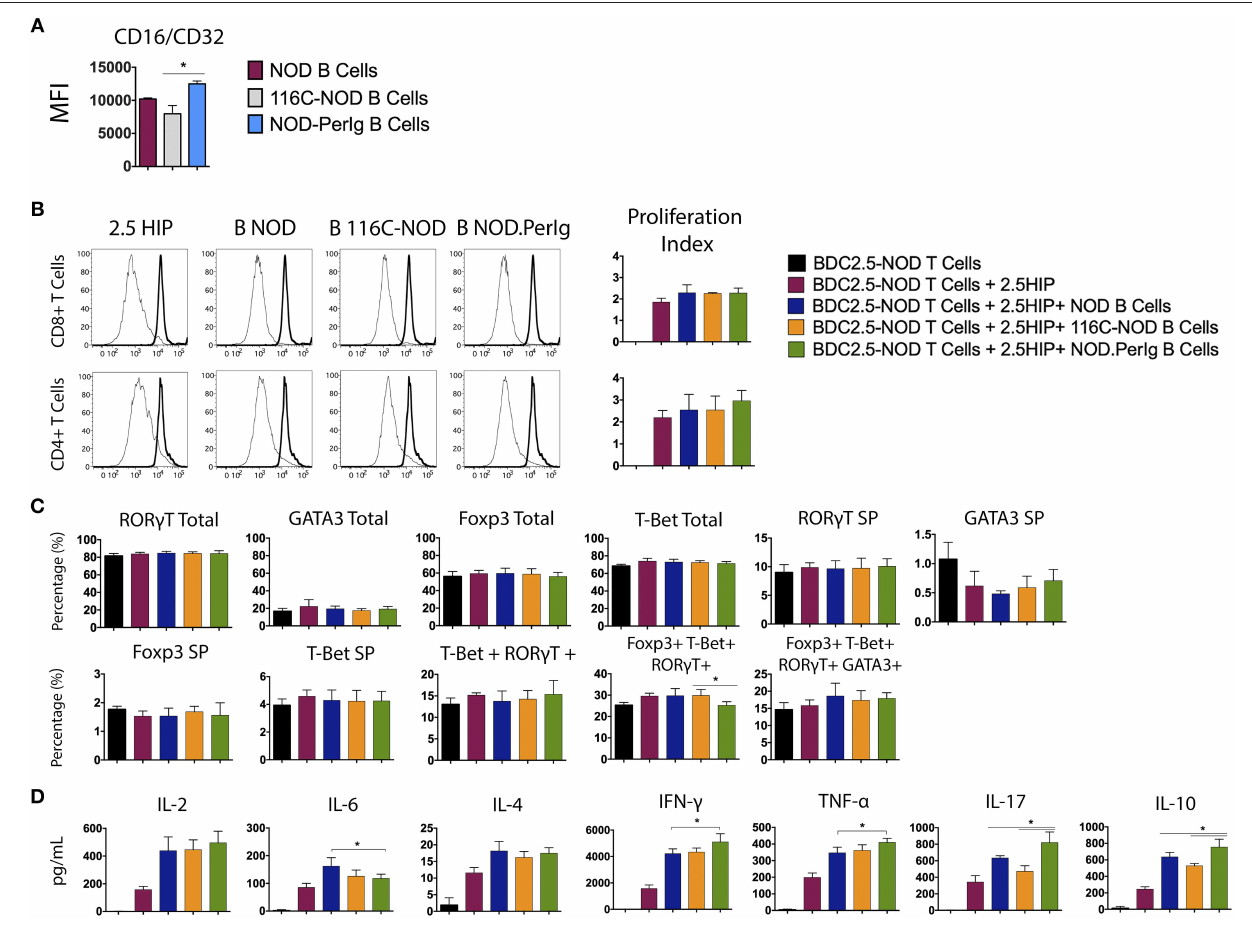
FIGURE 6 | Analysis of BDC2.5-NOD T-lymphocyte activation after co-culture with B-lymphocytes from NOD, 116C-NOD, and NOD -PerIg mice. (A) The expression of Fc Receptors (CD16/CD32) from B-lymphocytes was analyzed by flow cytometry before culture ( n = 4 per group). (B) BDC2.5 - NOD T-lymphocyte proliferation assay. Purified splenic T-lymphocytes from BDC2.5-NOD mice were CFSE-labeled and cultured in the presence of 2.5HIP alone and with purified NOD, 116C-NOD, or NOD- PerIg B-lymphocytes, or without stimulus for 72h. (C) Transcription factor expression was analyzed after culturing cells as mentioned above. “Total” and “SP” stand for the percentage of “whole positive” and “single positive” cells for the aforementioned marker, respectively. (D) Cytokine release was checked in supernatants after 72h. Bars show the SD of the percentage values or cytokine concentrations. In all experiments N = 4. Mann-Whitney U, statistically significant differences: * P <